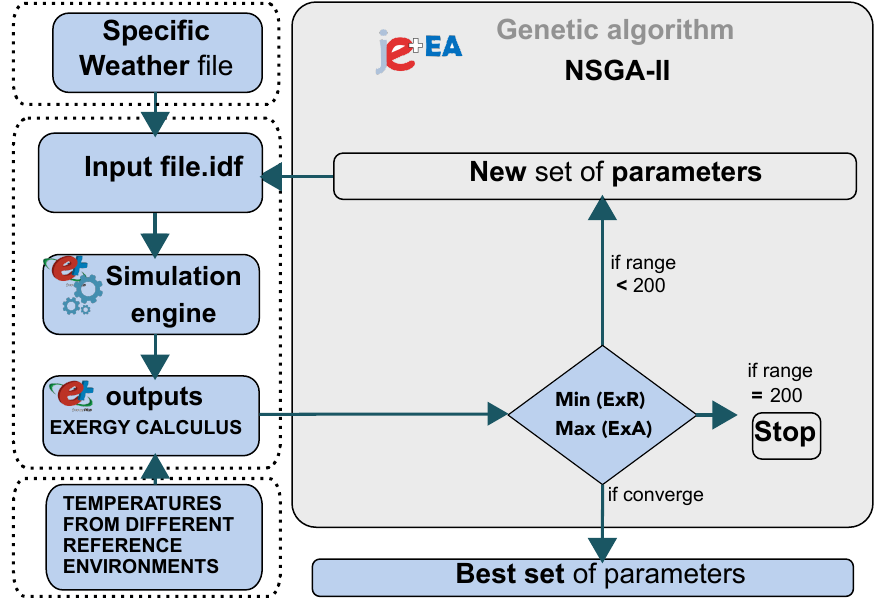
Figure 9. Assembly of the optimization